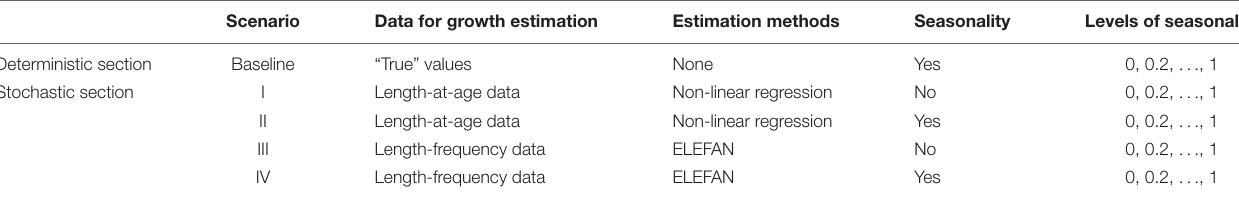
TABLE 2 | Simulation scenarios for testing the impact of seasonality on estimation of biological reference points.